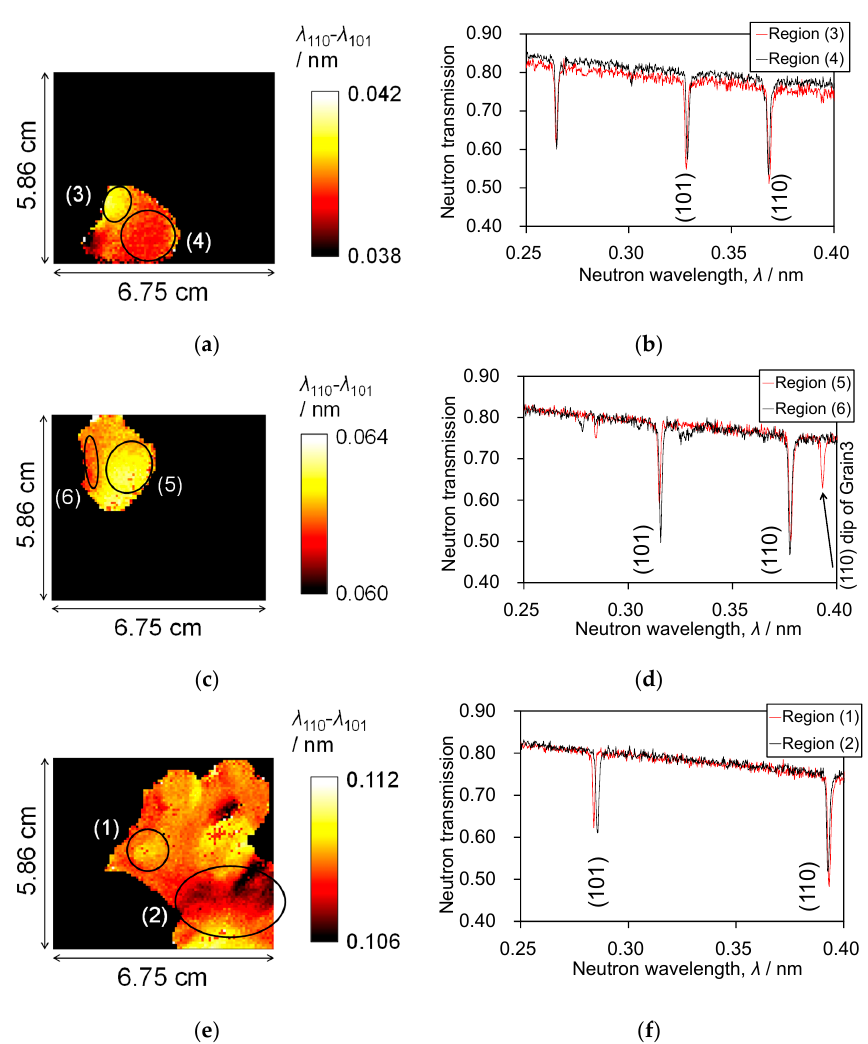
Figure 6. ( a ) Imaging of the interval between (110) Bragg-dip wavelength and (101) Bragg-dip wavelength of Grain 1. ( b ) Neutron transmission spectra of Regions (3) and (4). ( c ) Imaging of the interval between (110) Bragg-dip wavelength and (101) Bragg-dip wavelength of Grain 2. ( d ) Neutron transmission spectra of Regions (5) and (6). ( e ) Imaging of the interval between (110) Bragg-dip wavelength and (101) Bragg-dip wavelength of Grain 3. ( f ) Neutron transmission spectra of Regions (1) and